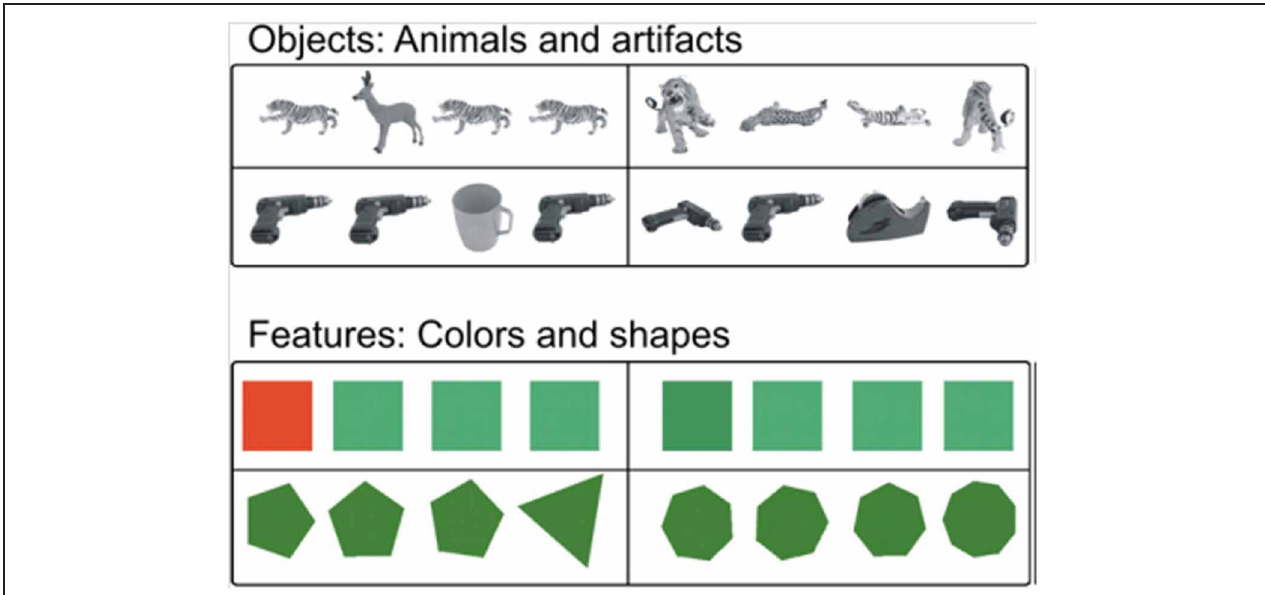
FIGURE 9 | Example stimuli from Devlin and Price (2007). Easy (left column) and difficulty (right column) trials are shown for common objects (top rows) and feature stimuli (lower rows). This task is almost identical to visual